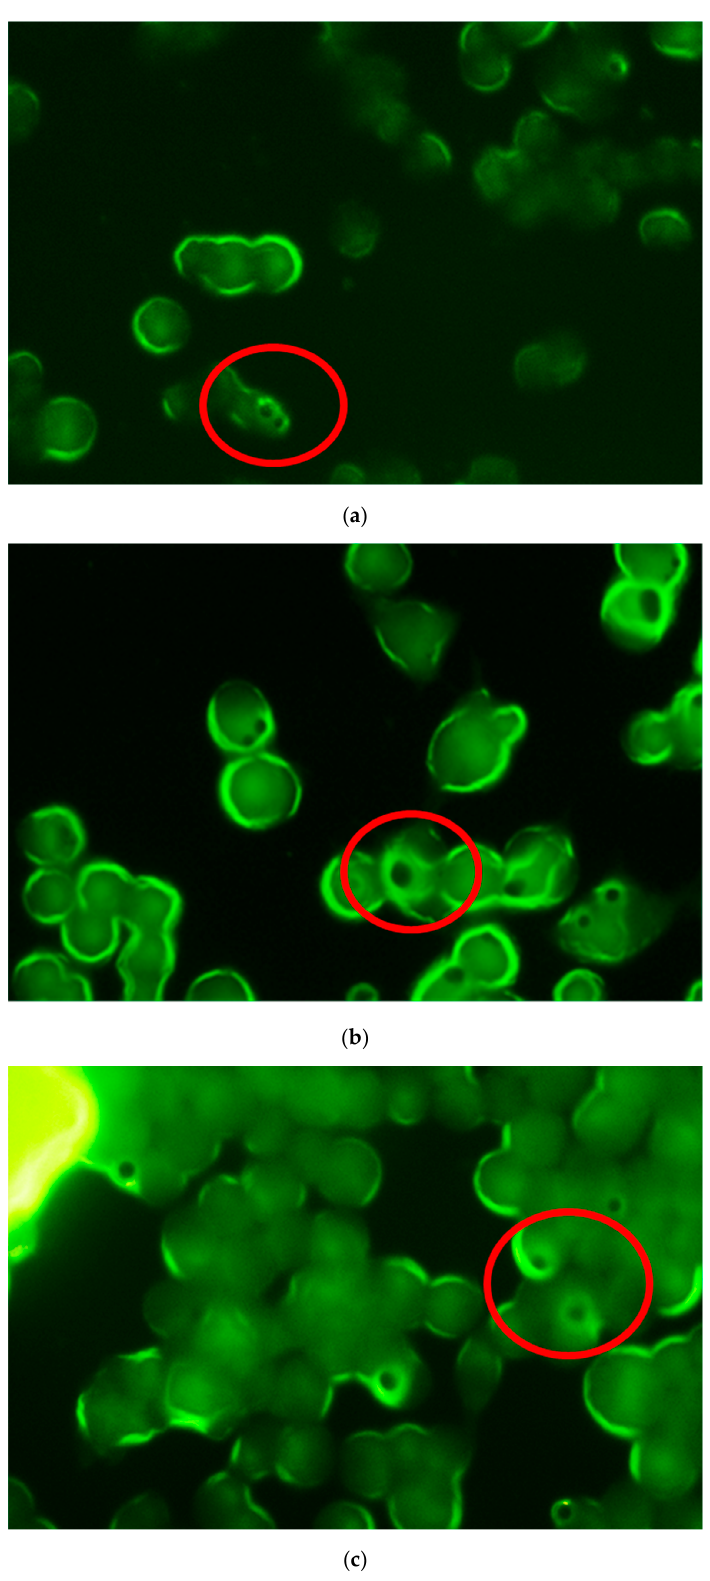
Figure 5. Fluorescence microscopy images of RAW 264.7 macrophages acquired at different times after incubation with formulation ( a ) MP-F: 1 h, ( b ) 5 h and ( c ) 24 h. MP-F: FITC-loaded PLGA MPs. FITC: fluorescein-5-isothiocyanate.